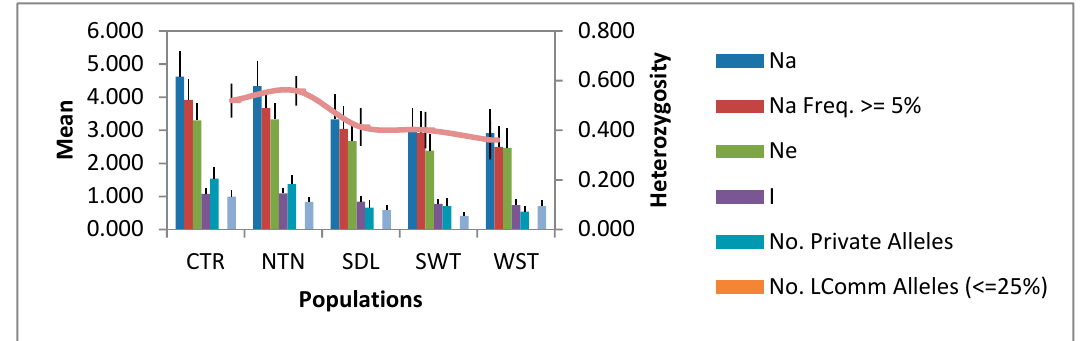
Figure 2. Allelic patterns across the study populations of Brachiaria grass ecotypes in Uganda. CTR = central, NTN = northern, SDL = southern dryland, SWT = southwestern, and WST = western. Na = number of different alleles, Ne = number of effective alleles, and I = Shannon information index.